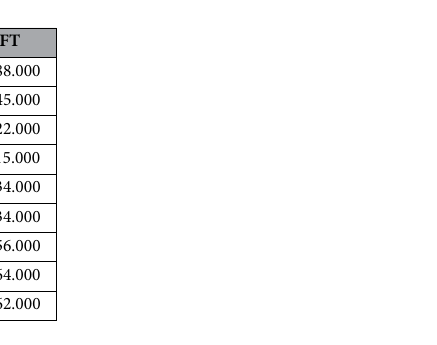
Table 5. Calculation results of cementite elastic